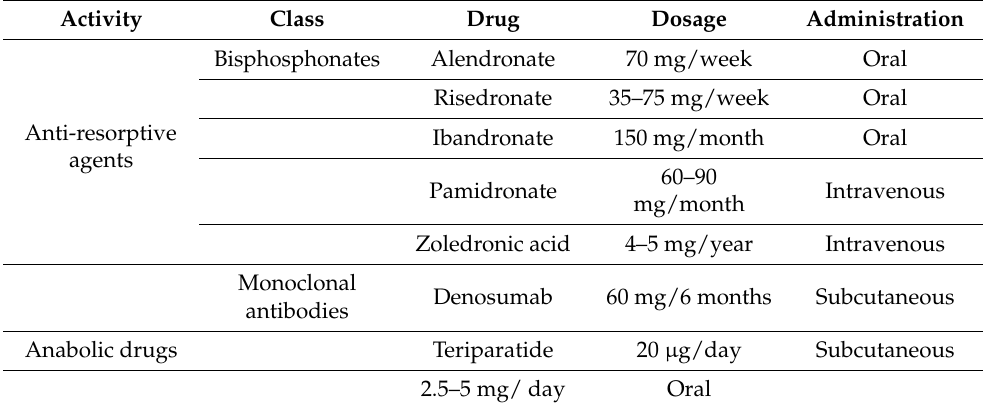
Table 1. List of pharmacological countermeasures, related dosages and administration routes pro- posed for the treatment of microgravity-induced